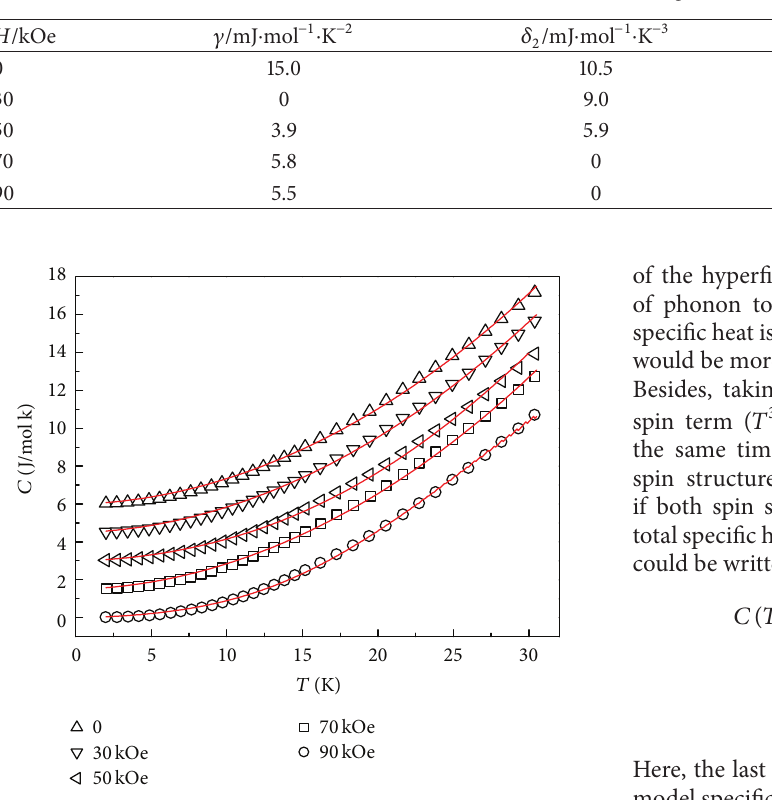
Table 1: Parameters under different magnetic fields fitting to (2).